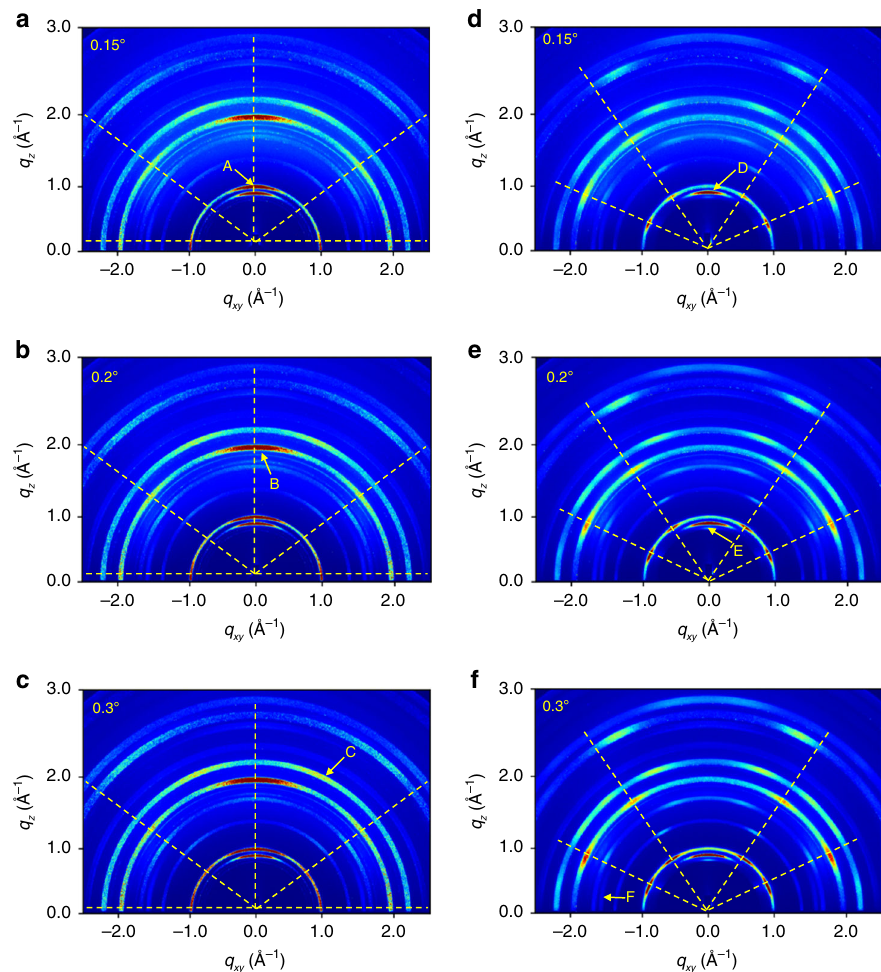
Fig. 3 GIWAXS 2D patterns for control-HaP ( a – c ) and w/-PbI 2 -HaP ( d – f ) at different X-ray grazing-incidence angles such as 0.15°( a ) and ( d ), 0.20° ( b ) and ( e ), and 0.3° ( c ) and ( f ), measured at 11.6 keV for 10 s. Peaks A, B, C, D, E, and F are assigned to α [100] cubic , α [200] cubic , α [210] cubic , α [100] trigonal of PbI 2 , δ [100] hexagonal , and δ [002] hexagonal in this HaP fi lm,